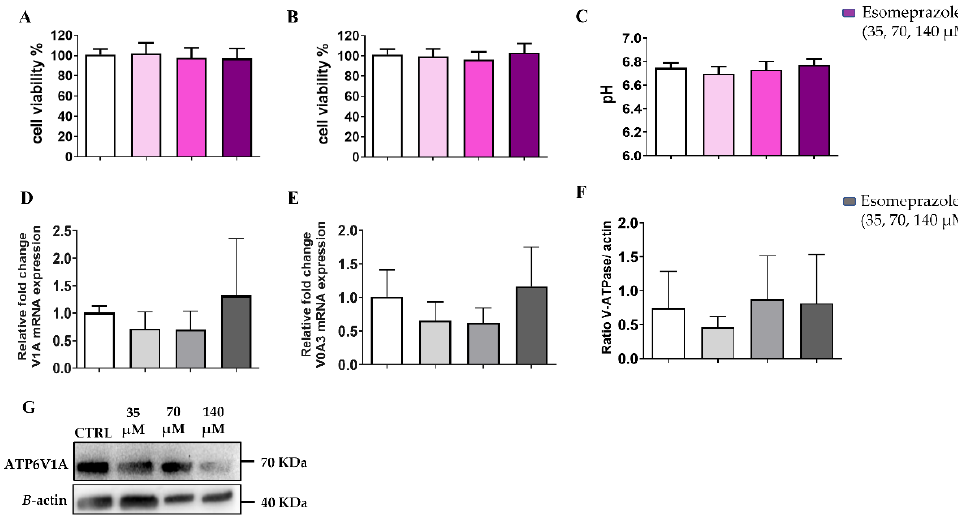
Figure 9. Cell viability assays in normoxia ( A ) and in hypoxia ( B ) and pH measurements ( C ) assays for PC3 acidic-conditioned (pH = 6.8, in normoxia) cells treated with Esomeprazole. V-ATPase mRNA expression for the subunits V1A ( D ) and V0A3 ( E ). Quantification of protein level ( F ) and Western Blot analysis ( G ) of PC3 conditioned at acidic pH after 24 h Esomeprazole treatment. White columns represent the control; grey-or-violet-colored columns represent the three different concentrations of esomeprazole. ANOVA statistical analysis with Bonferroni post-hoc correction was applied.